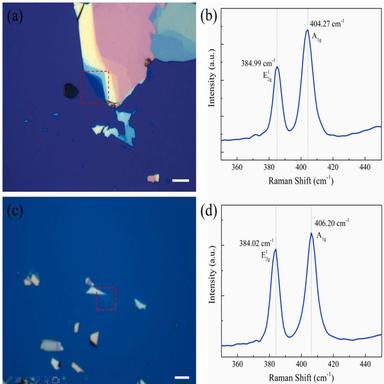
Suspicious ROI region and Raman spectrum (10 μm in scale). (a) monolayer MoS2 sample. (b) Raman spectra of monolayer MoS2 sample. (c) Few-layer MoS2 sample. (d) Raman spectra of MoS2 few-layer sample.